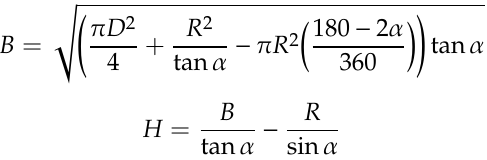
Figure 4. Global boundary conditions in FE Models.